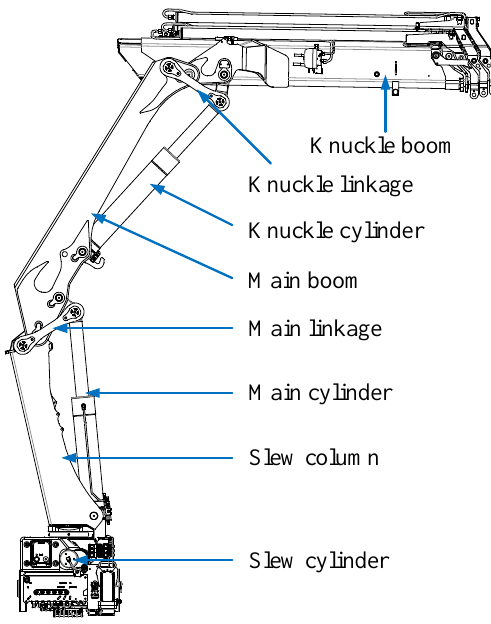
Figure 3. Illustration of the HMF 2020K4 loader